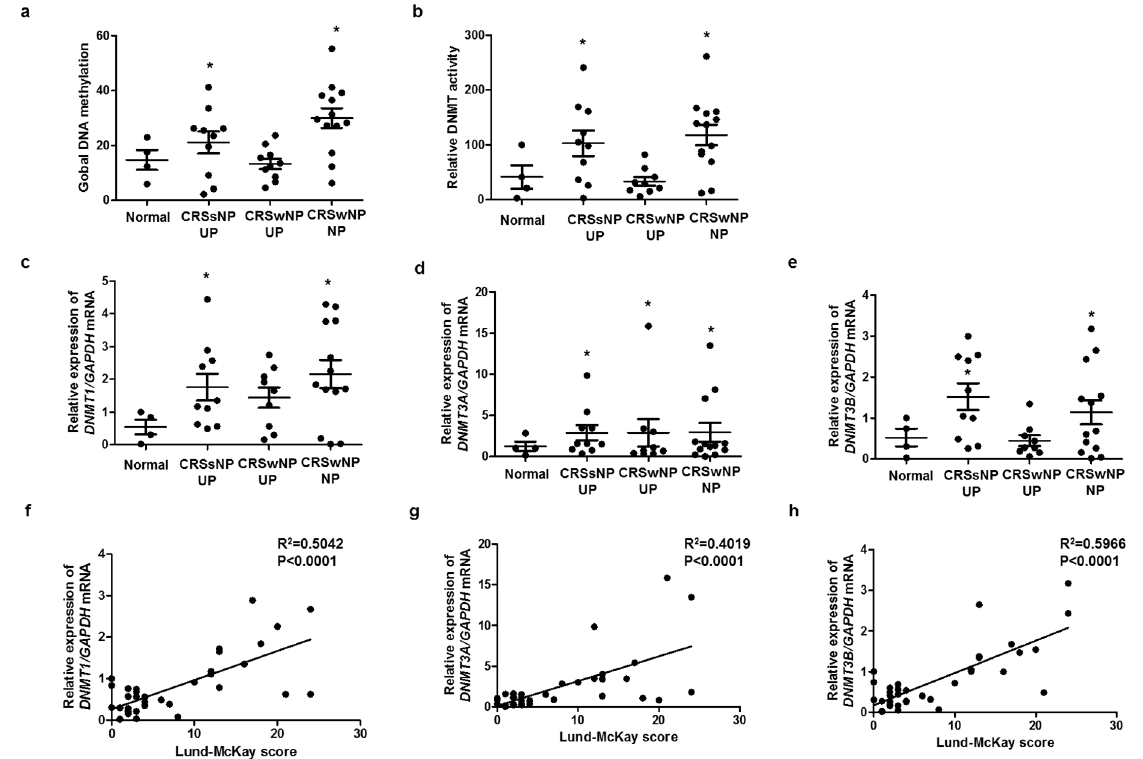
Figure 1. DNA methylation and DNMT expression in nasal tissues: ( a ) global DNA methylation and ( b ) DNMT activity were analyzed using a Global DNA Methylation Assay Kit and DNMT Activa-